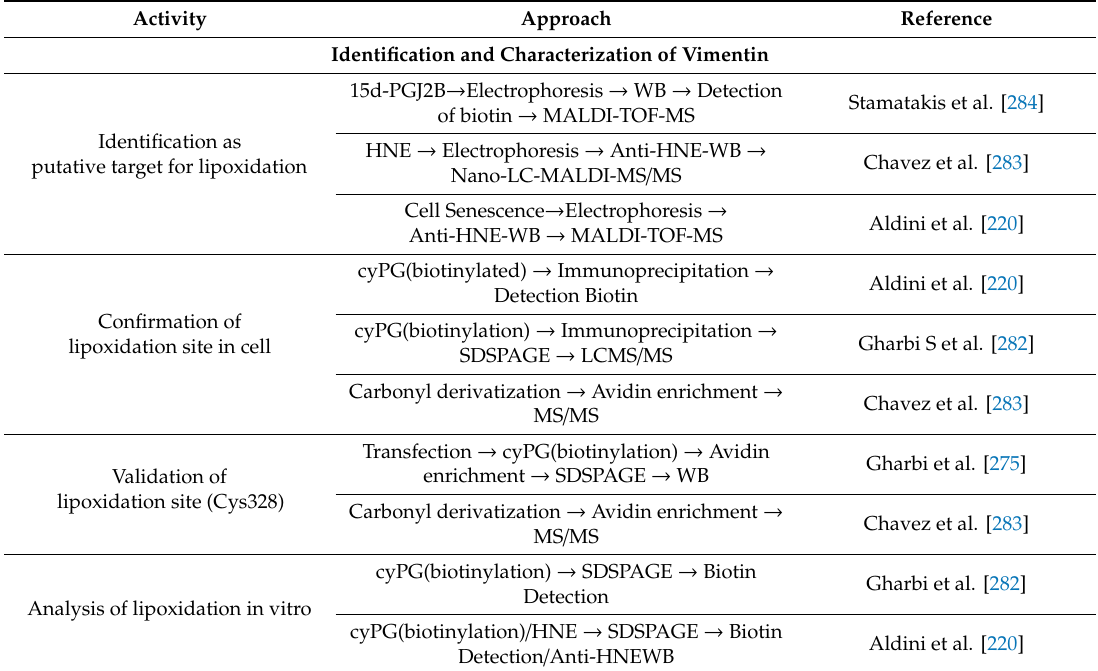
Table 1. Combination of approaches to characterize vimentin lipoxidation and assessment of consequences of vimentin